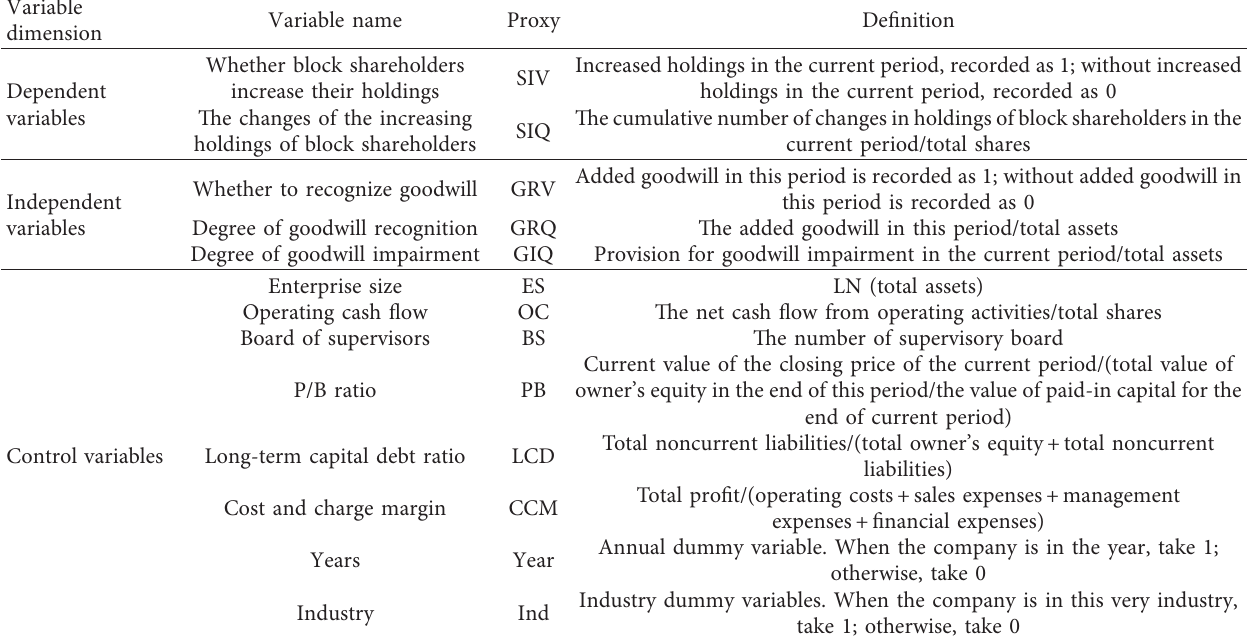
Table 1: Variable